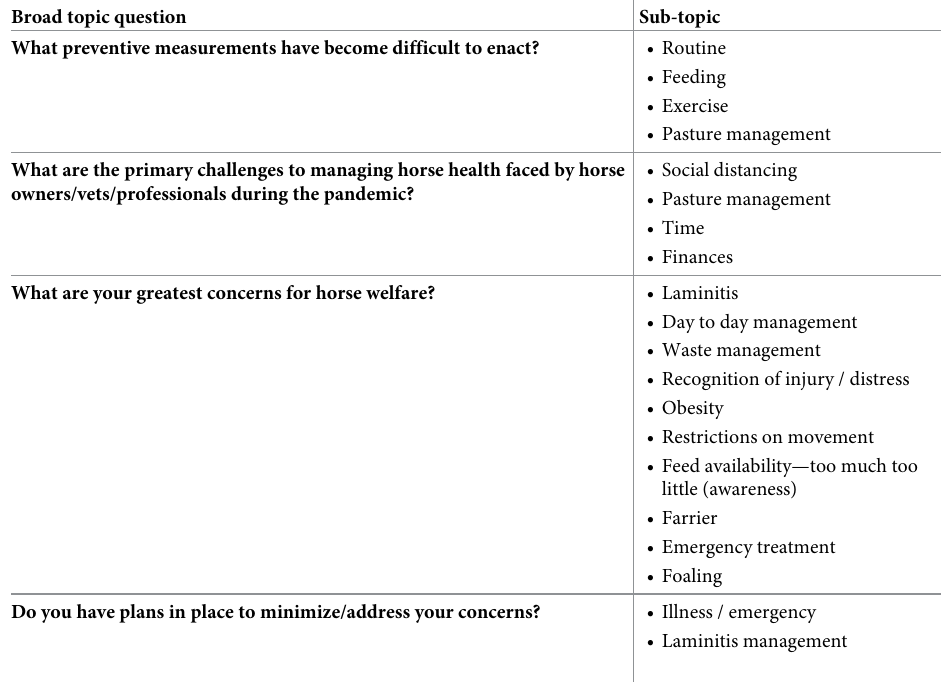
Table 1. Predefined interview questions with sub-topic probes which interviewees were asked. Broad topic